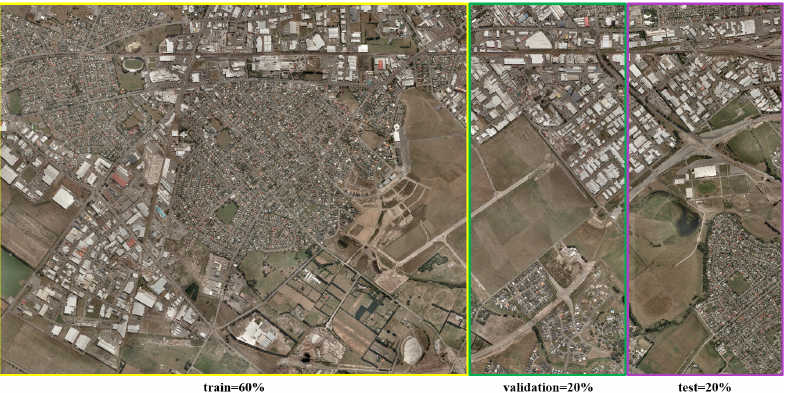
Figure 7. The split of train/validation/test sets of the WHU dataset. The rectangles in different colors represent different